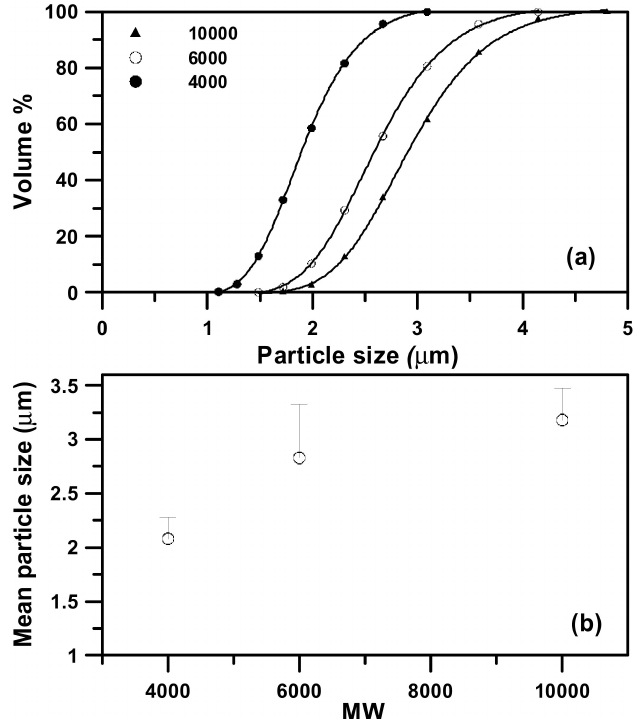
Figure 9. ( a ) The particle size distributions of the sample produced by the LTSAA process at di ff erent molecular weights of PEG ( MW ) from 4000 to 10000. ( b ) Mass-weighted mean particle size ( with molecular weight of PEG ( MW ) at C = 10 mg / mL, T S = 323.2 K, and R =